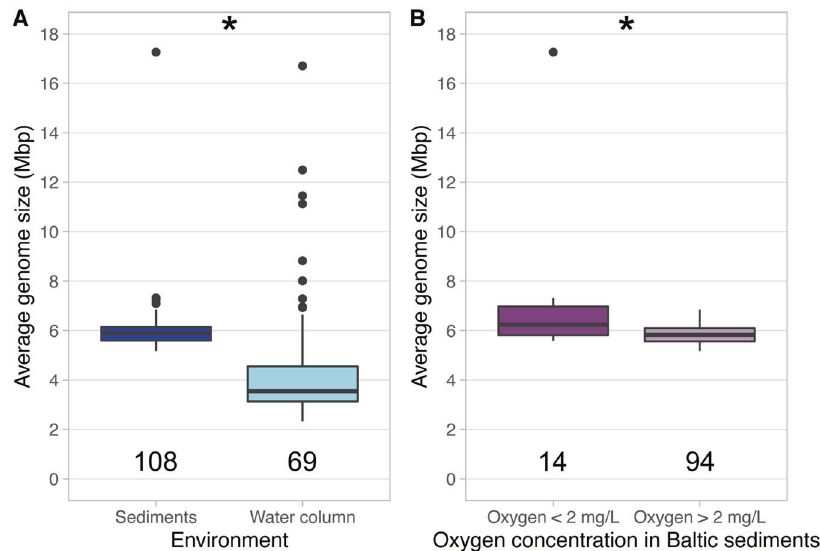
Fig. 2 Boxplots showing the AGS distribution of Baltic metagenomes. A Indicates the AGS distribution in both water column and sediments. B Indicates the AGS distribution in metagenomes from sediments across the oxygen gradient (two groups, from 0 to 2 and from 2 to 12.45 mg/L). Stars in both panels indicate signi fi cant differences p < 0.05 (Wilcoxon non-parametric